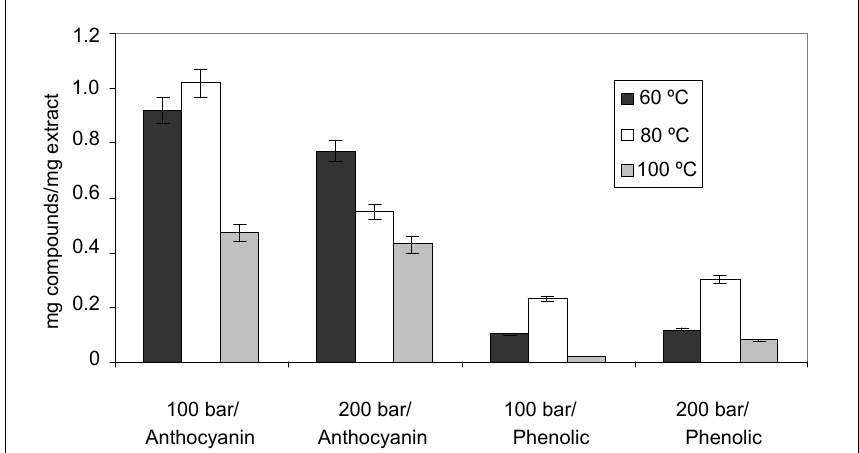
Figure 5. Anthocyanin and phenolic concentration of extracts obtained by PLE at different pressures and